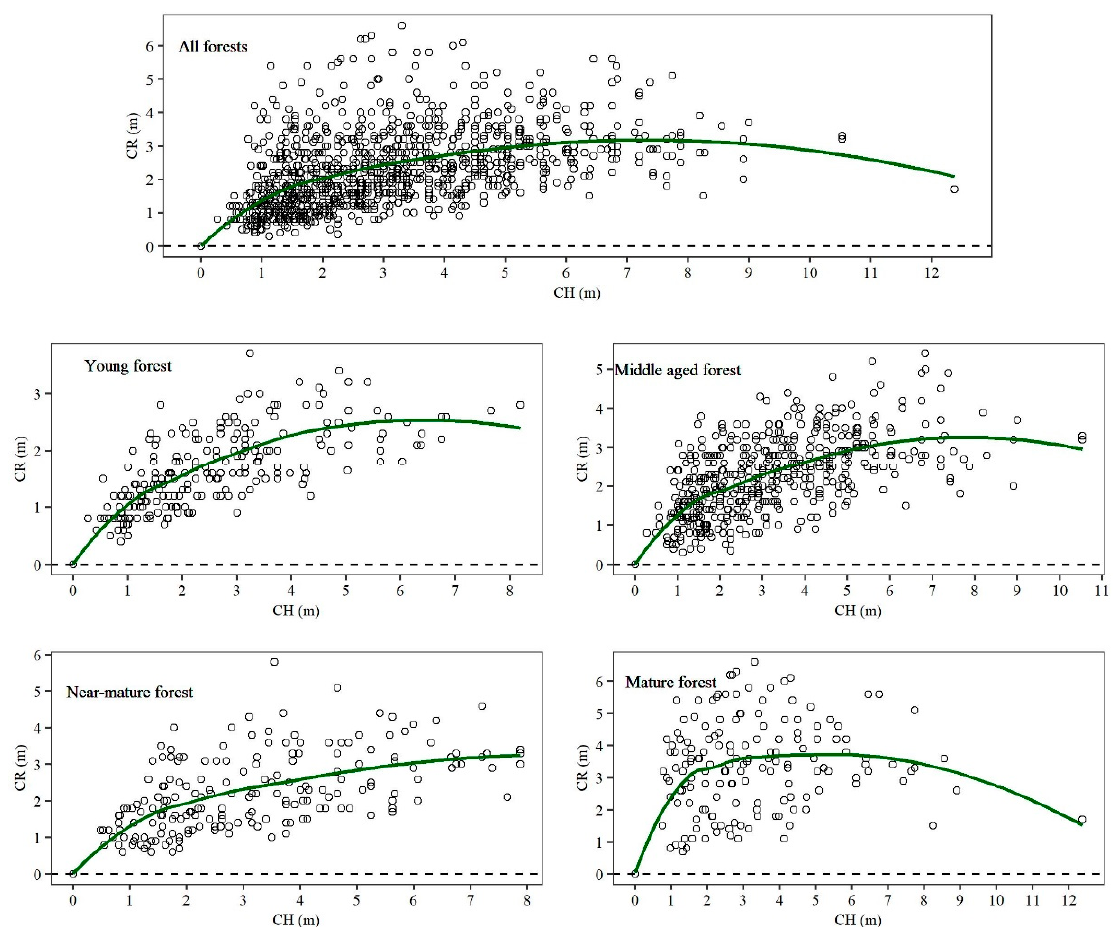
Figure 2. CR and CH plotted with a local regression loess smoothing curve (all forests: 5–35 years, young forest: ≤ 10 years, middle aged forest: 11–20 years, near-mature forest: 21–25 years, mature forest:26–35 years).